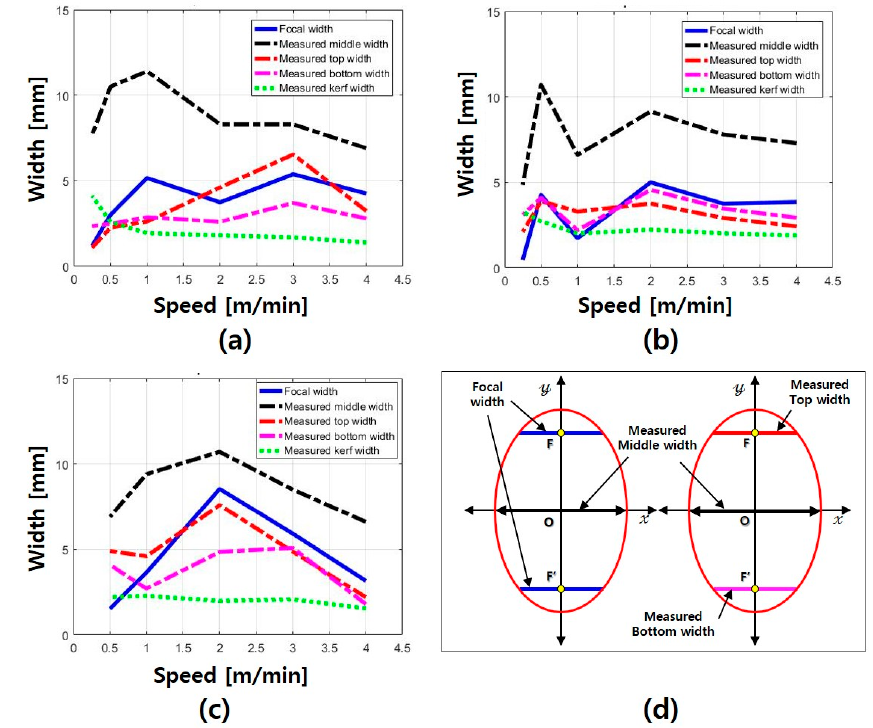
Figure 12. Width comparison for ( a ) LP 0.25, ( b ) LP 0.35, and ( c ) LP 0.4, and ( d ) position of measured and focal widths of elliptical hole.